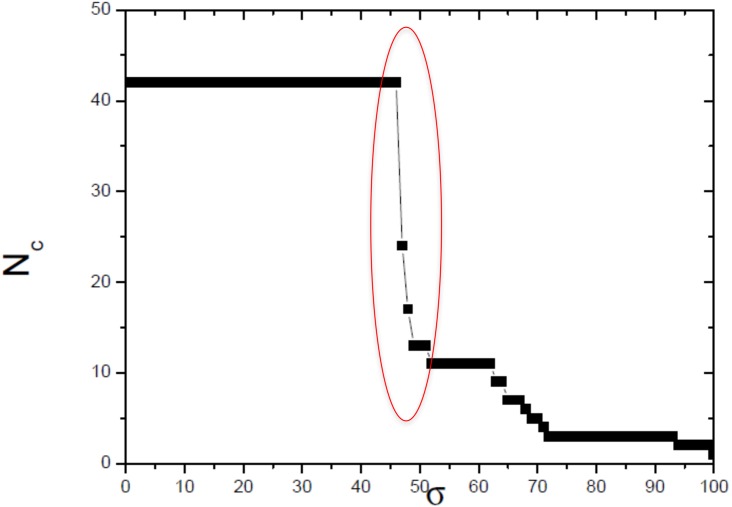
Size of the largest connected component (Nc) versus the threshold similarity σ.Near the critical value, there is an abrupt topological change with the disaggregation of a sole network completely connected in groups that can be discerned, with maximum phylogenetically-relevant information in relation to noise, enabling the detection of communities (modules) in the network.